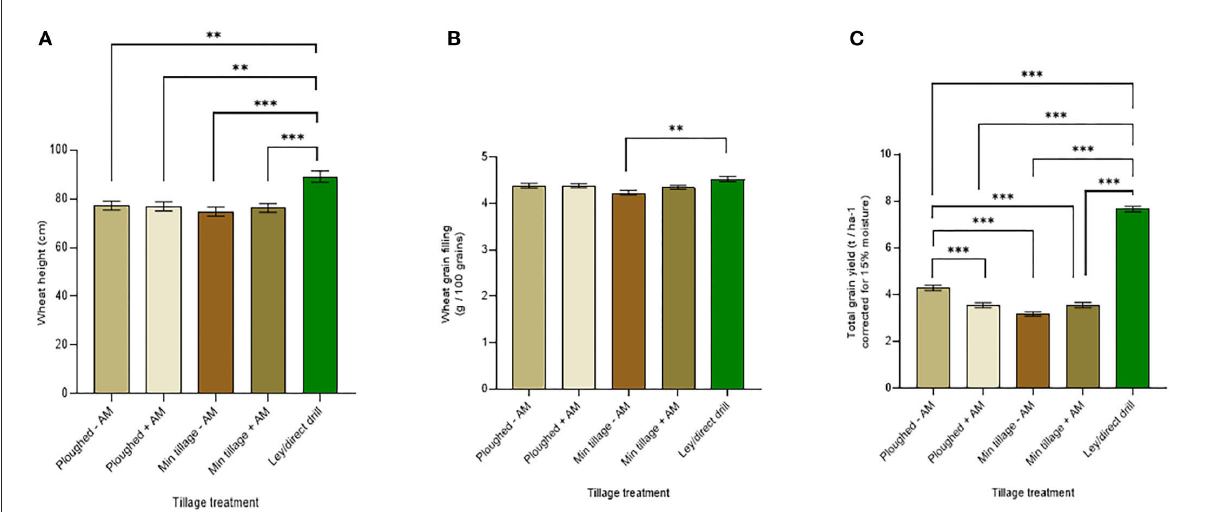
FIGURE4 Wheat performance averaged across genotypes on ploughed and minimally tilled plots, with added sterile carrier (- AM) or commercial AMF inoculum ( + AM) compared to direct drilling into ley at the 2018 harvest. (A) wheat tiller height (cm) (ploughed – n = 24, ploughed + n = 24, min tillage – n = 24, min tillage + n = 28, and ley n = 24), (B) grain weight (g / 100 grains) (ploughed – n = 24, ploughed + n = 24, min tillage – n = 24, min tillage + n = 23, and ley n = 24), and (C) total grain yield (corrected for 15% moisture, t ha − 1 ) (ploughed – n = 24, ploughed + n = 24, min tillage – n = 24, min tillage + n = 24, and ley n = 24). The error bars show ± 1 SE. Results of significant Tukey’s HSD test results of significant differences are shown on the graphs * p = 0.05; ** p = 0.001; *** p < 0.0001 ).